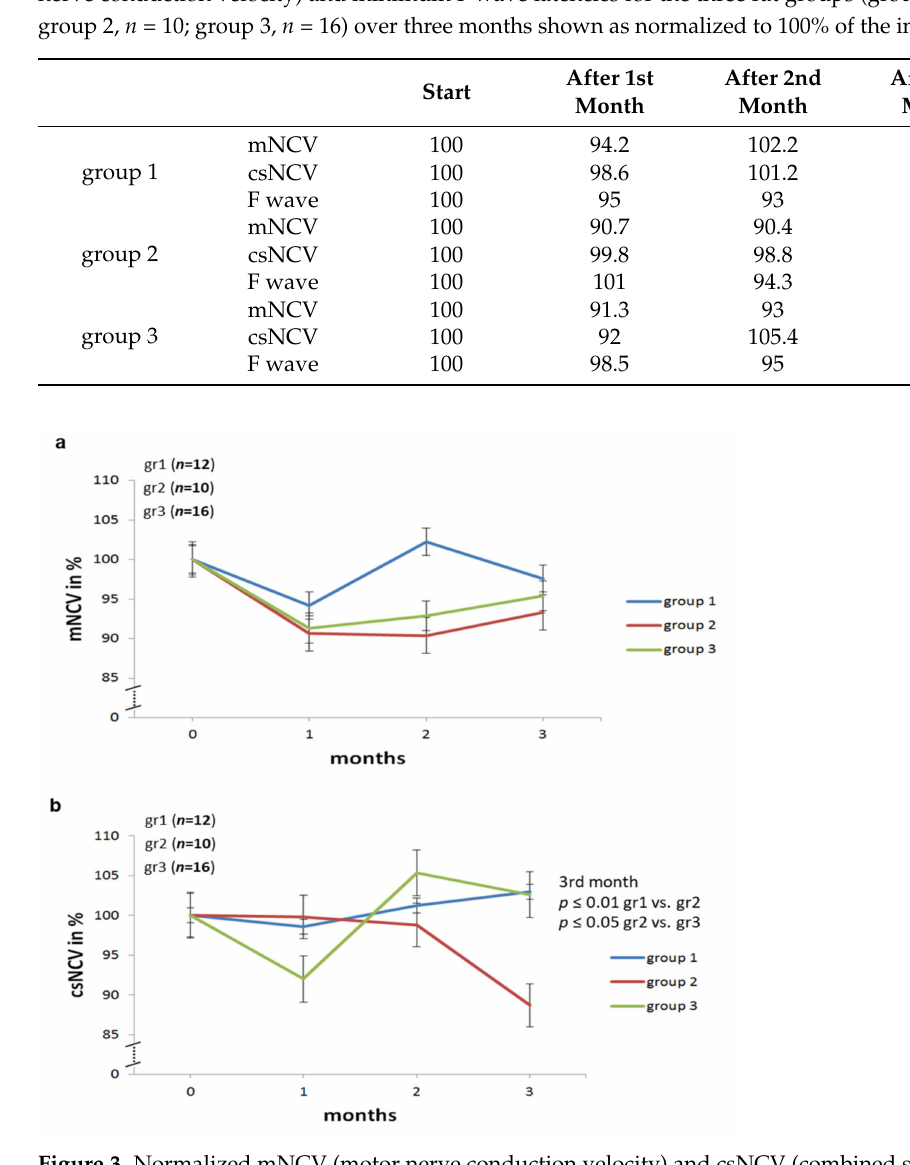
Figure 3. Normalized mNCV (motor nerve conduction velocity) and csNCV (combined sesorimotor nerve conduction velocity) values in percent of the initial values for each time point in sciatic nerve of BB/OKL rats in three groups. ( a ) No significant differences in motor NCV were found between animal groups. ( b ) The sensory/mixed afferent NCV was significantly reduced in group 2 rats ( n = 10) vs. group 1 ( n = 12) and group 3 ( n = 16) rats (mean values ± SD are given in Table